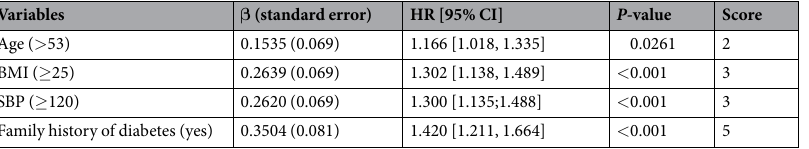
Table 3. Multivariate model of the KARE cohort. * We corrected for the effects of gender, maintaining it in the model. Also, we included high-density lipoprotein cholesterol (HDL) and triglycerides, which were significant in the multivariate model, but we did not compute a score for them because they were not present in the KNDP cohort (many missing values for these variables). The English in this document has been checked by at least two professional editors, both native speakers of English. For a certificate, please see: http://www.textcheck.com/ certificate/YetViu.